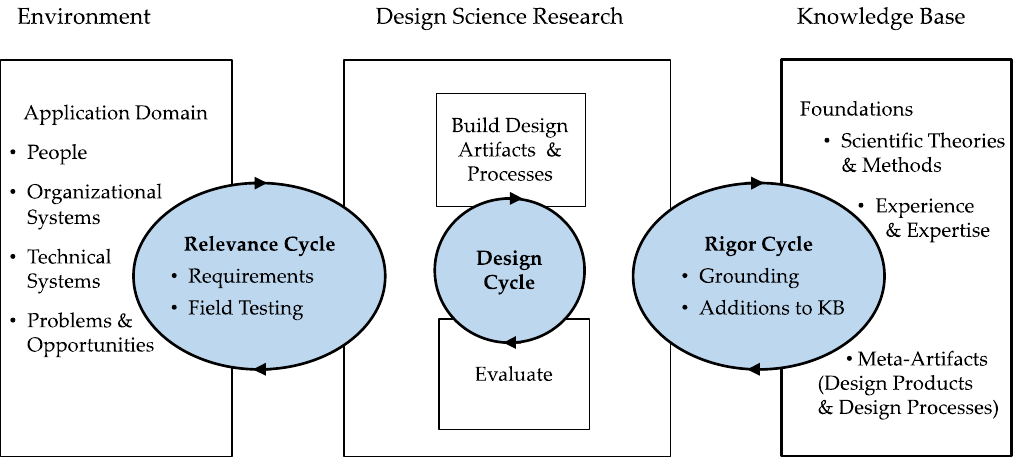
Figure 1. Design Science Research (DSR) cycles adapted from Hevner’s study [52].